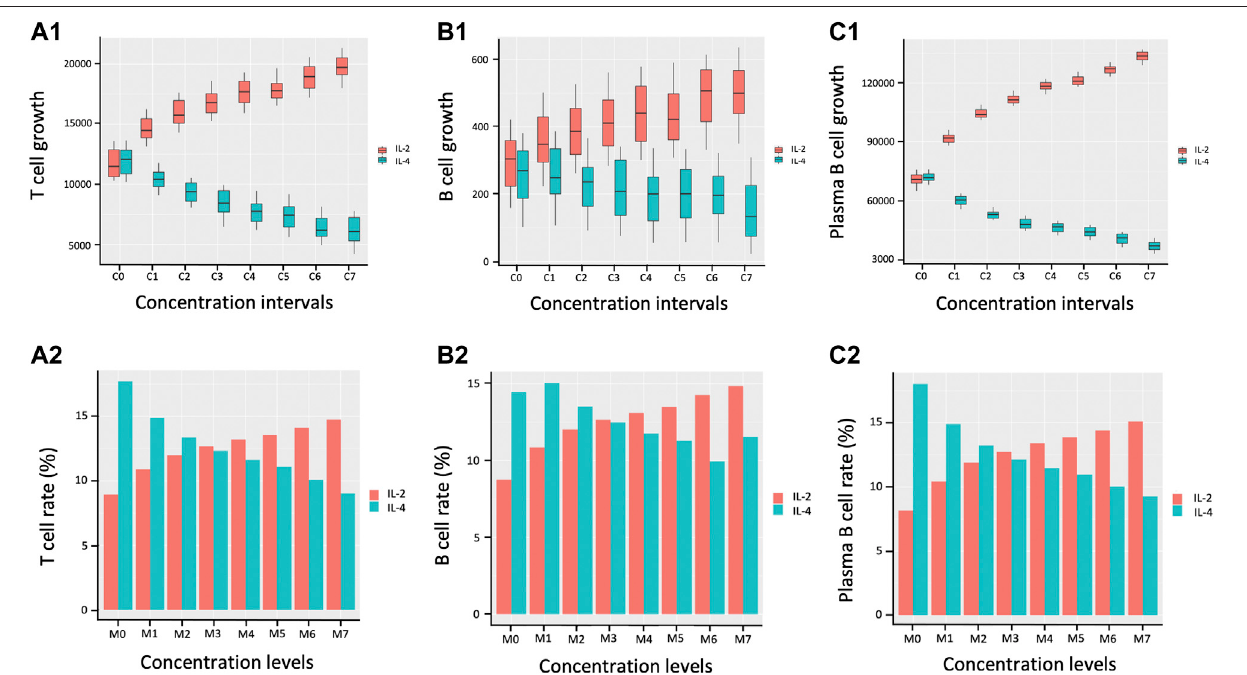
FIGURE 6 | Proliferation growth and percentage growth rate of lymphocytes during immune response. C0, C1, C2, C3, C4, C5, C6, and C7 represent eight matched concentration intervals of IL-2 and IL-4 in pM respectively: C 0 (cid:2) [ 0 − 0 . 75 ] , C 1 (cid:2) [ 0 . 76 − 1 . 5 ] , C 2 (cid:2) [ 1 . 51 − 2 . 25 ] , C 3 (cid:2) [ 2 . 26 − 3 ] , C 4 (cid:2) [ 3 . 01 − 3 . 75 ] , C 5 (cid:2) [ 3 . 76 − 4 . 5 ] , C 6 (cid:2) [ 4 . 51 − 5 . 25 ] , C 7 (cid:2) [ 5 . 26 − 6 ] . For each range of concentration of cytokines IL-2 and IL-4, 50 random samples are generated uniformly. The distribution and maximal levels of helper T cells, B cells and plasma B cells produced during their proliferation time are evaluated for each concentration sample of cytokines. The parameter values used to obtain these plots are shown in Table 2 . In (A1) , (B1) , and (C1) , the lymphocyte proliferation growth displays a decrease in growth average patterns with decrease in the concentration levels of IL-2 with a corresponding rise of the concentration of IL-4. M0, M1, M2, M3, M4, M5, M6, and M7 representeight matched averageconcentration ofintervals C0,C1, C2,C3, C4,C5, C6,and C7for IL-2and IL-4 in pM respectively: M 0 (cid:2) 0 . 37, M 1 (cid:2) 0 . 74, M 2 (cid:2) 1 . 11, M 3 (cid:2) 1 . 48, M 4 (cid:2) 1 . 85, M 5 (cid:2) 2 . 22, M 6 (cid:2) 2 . 6, M 7 (cid:2) 3. (A2) , (B2) , and (C2) , present the rate of proliferation growth of all the three lymphocytes which is approximately identicaltothegrowthpatternsregardlessofthevaryingconcentrationofIL-2andIL-4.ThisleadstotheconclusionthattheinterplaybetweenIL-2andIL-4hasidentical effects on T, B, and Plasma B cell proliferation